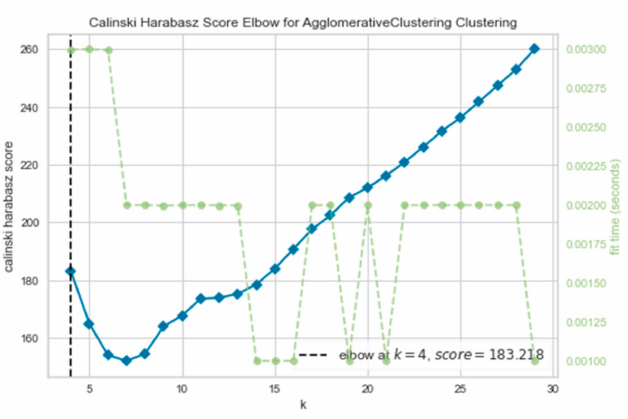
Figure 11. Calinski–Harabasz score graph for the proposed PCA-Ward while k =